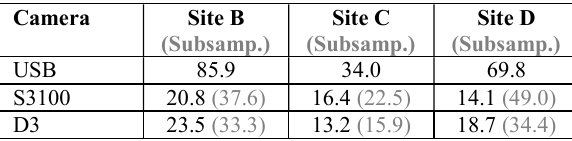
Table 5. Average residuals on the check points (in mm) for Sites A, B and C.